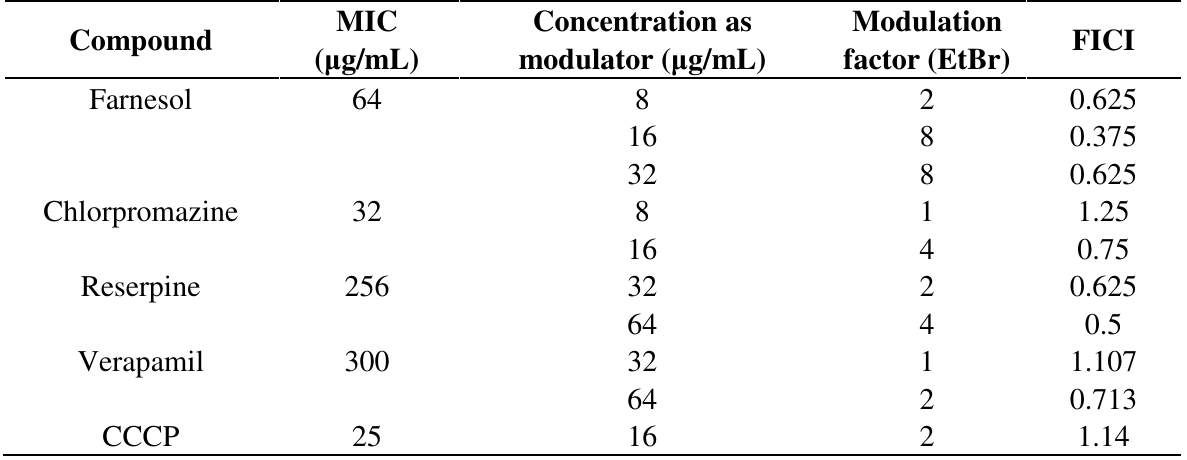
Table 1. MICs and checkerboard synergy of agents employed for M. smegmatis mc 2 155.